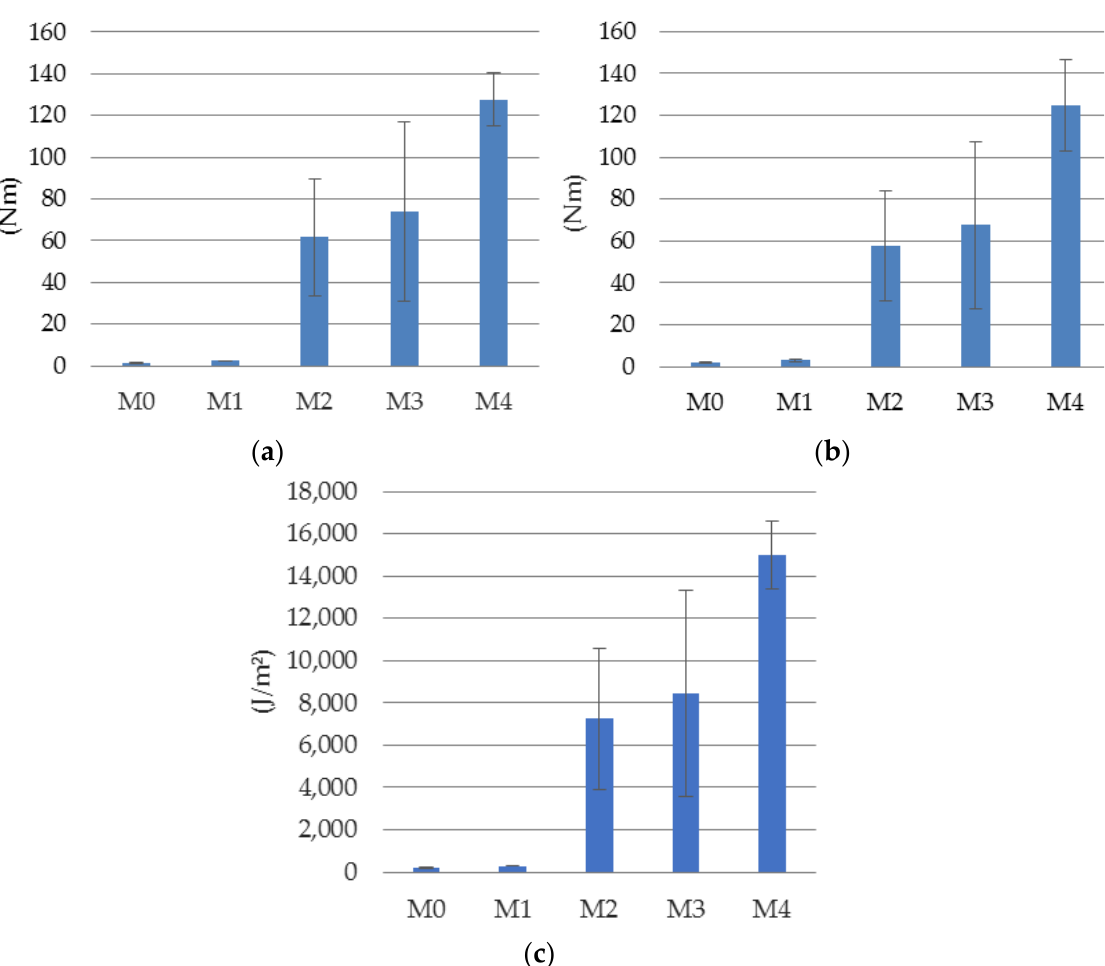
Figure 8. Energy dissipated during cracking—expressed the area under the curve: ( a ) F - u ( 𝑊 0𝑢 ) and ( b ) F - CMOD ( 𝑊 0𝐶𝑀𝑂𝐷 ), as well as ( c ) fracture energy 𝐺 𝐹 .